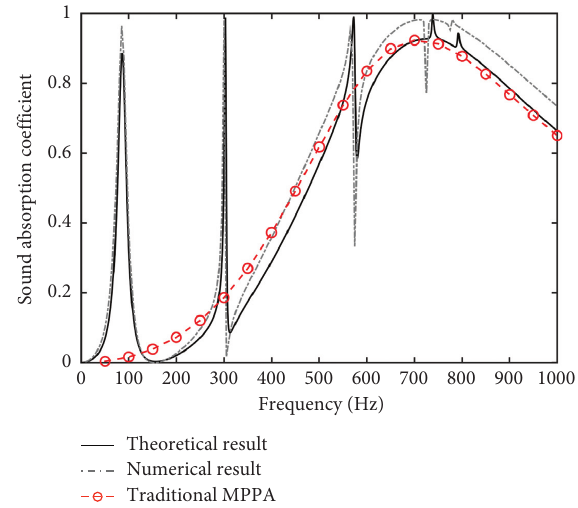
Figure 3: Comparison between the theoretical and numerical